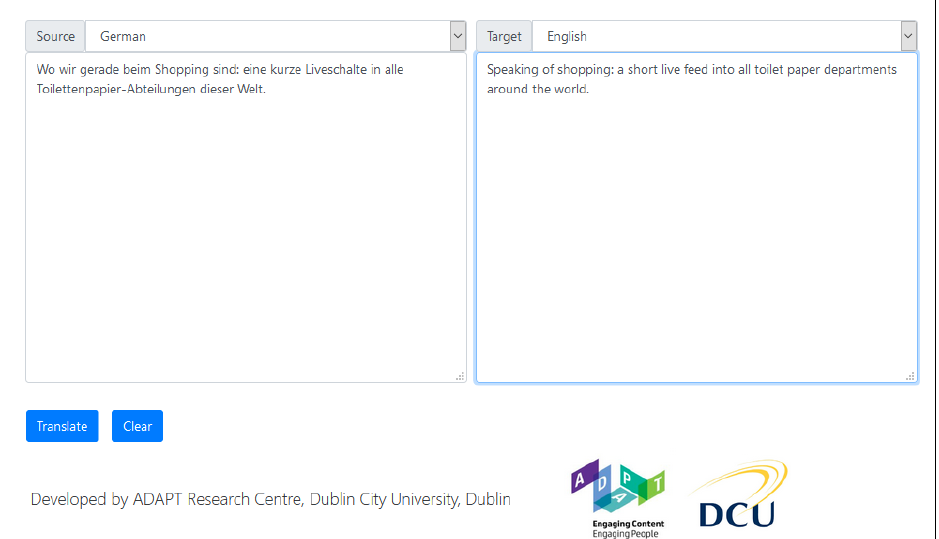
Figure 2. ADAPT COVID-19 Online MT System GUI, showing a sentence from Die Welt from 20/3/2020 translated into